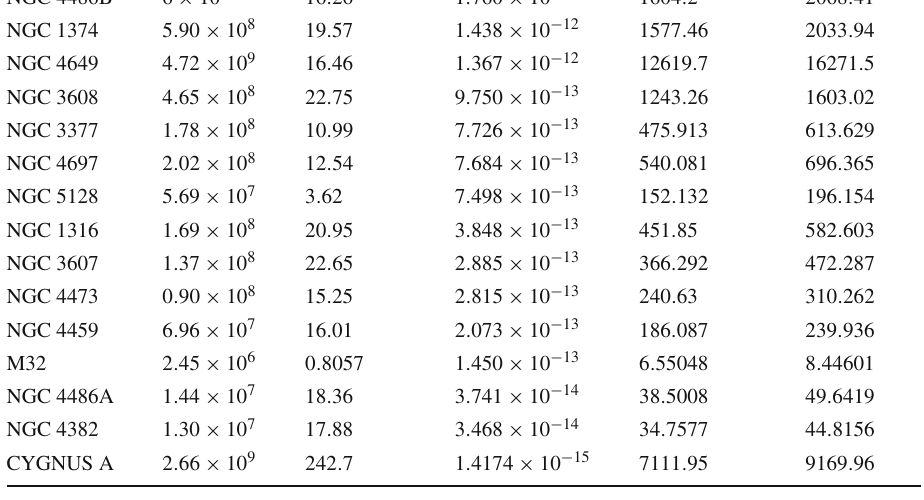
Table 3 Estimation of time delay for supermassive black holes at the center of nearby galaxies in the case Schwarzschild and hairy black holes in Horndeski gravity ( q = − 0 . 5 ) . Mass ( M ) and distance ( D OL ) are given in the units of solar mass and Mpc, respectively. Time Delays are expressed in minutes